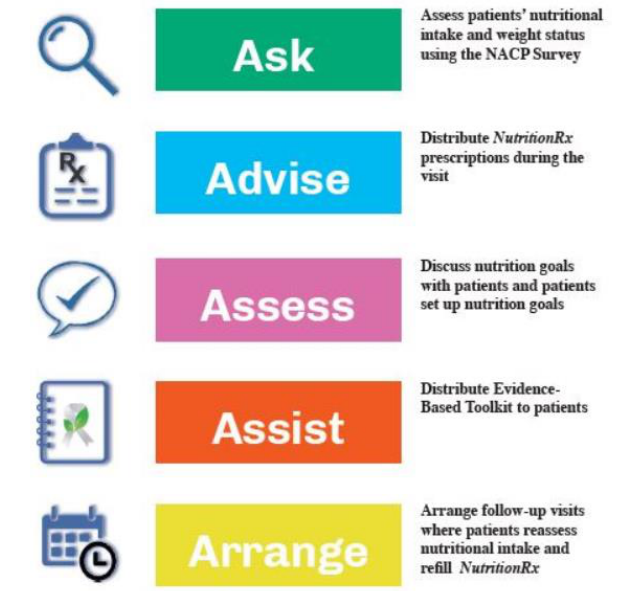
Figure 1. NutriCare Program Flowchart.